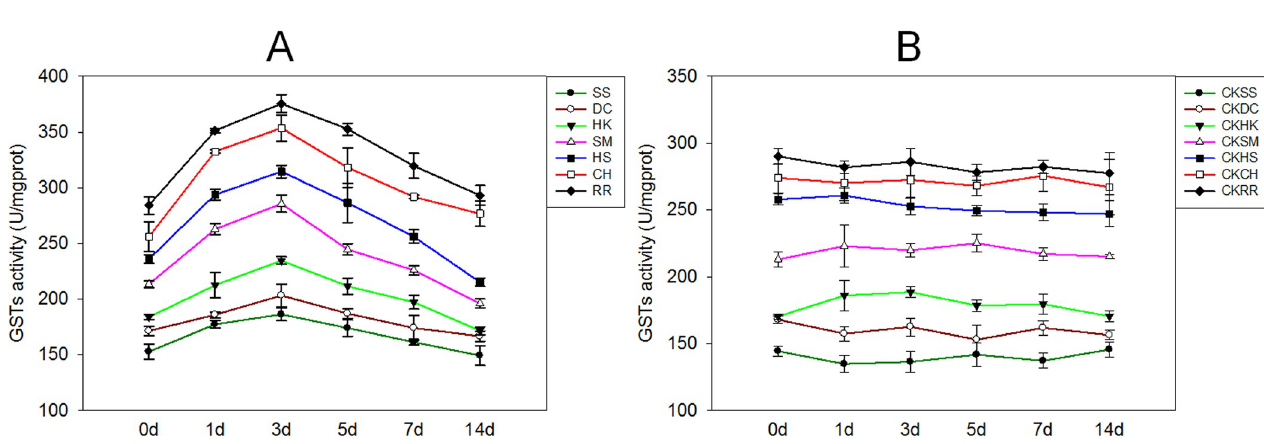
Fig 5. GST activity of E . crusgalli under 15% PEG-6000 treatment. (A) GST activity of E . crusgalli under 15% PEG-6000 treatment. (B) GST activity of E . crusgalli without PEG-6000 treatment. Data are expressed as least square means ± standard error.